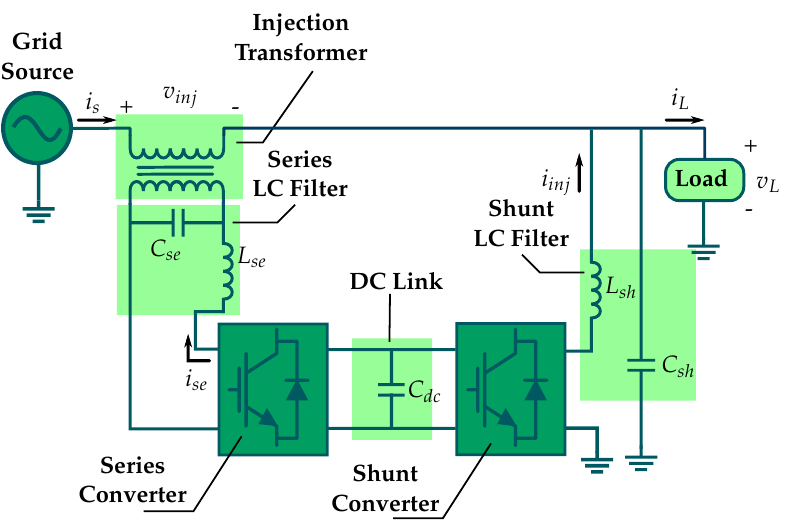
Figure 1. Stages of a UPQC for both voltage and current compensation.